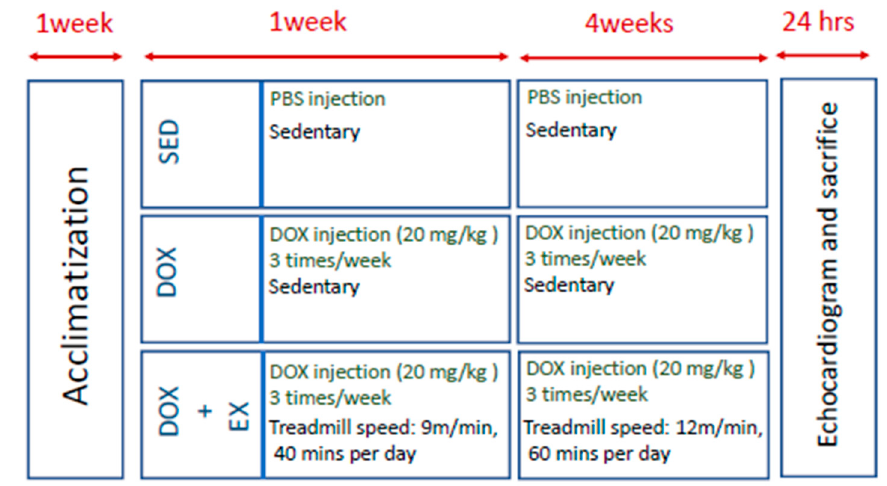
Figure 7. Schematic of the experimental paradigm After one week of acclimatization, all animals were assigned to three groups: sedentary group (SED), DOX-receiving group (DOX), and exercise during DOX treatment group (DOX + EX). All animals were subjected to echocardiography 24-h after the last intervention.